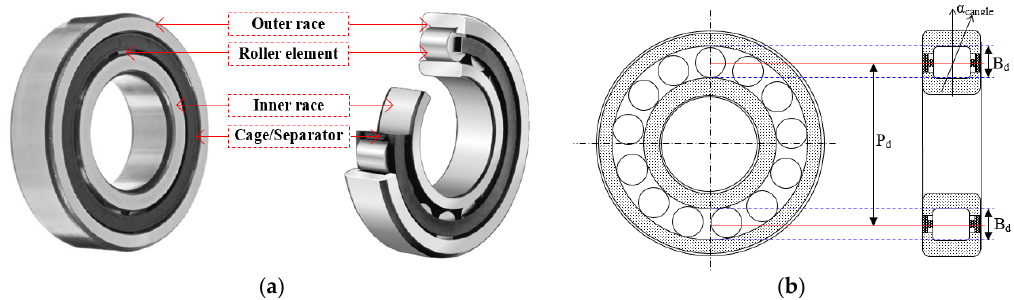
Figure 1. Block diagram of the experimental setup.